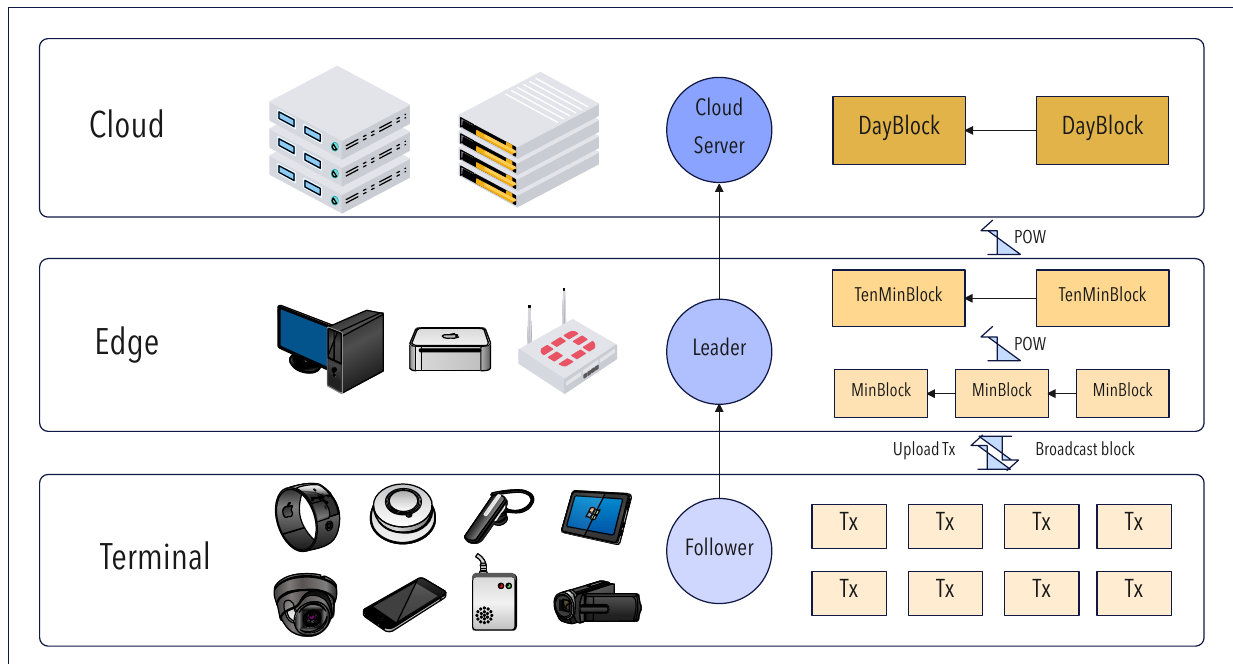
Figure 7. Hierarchical chain architecture and asynchronous